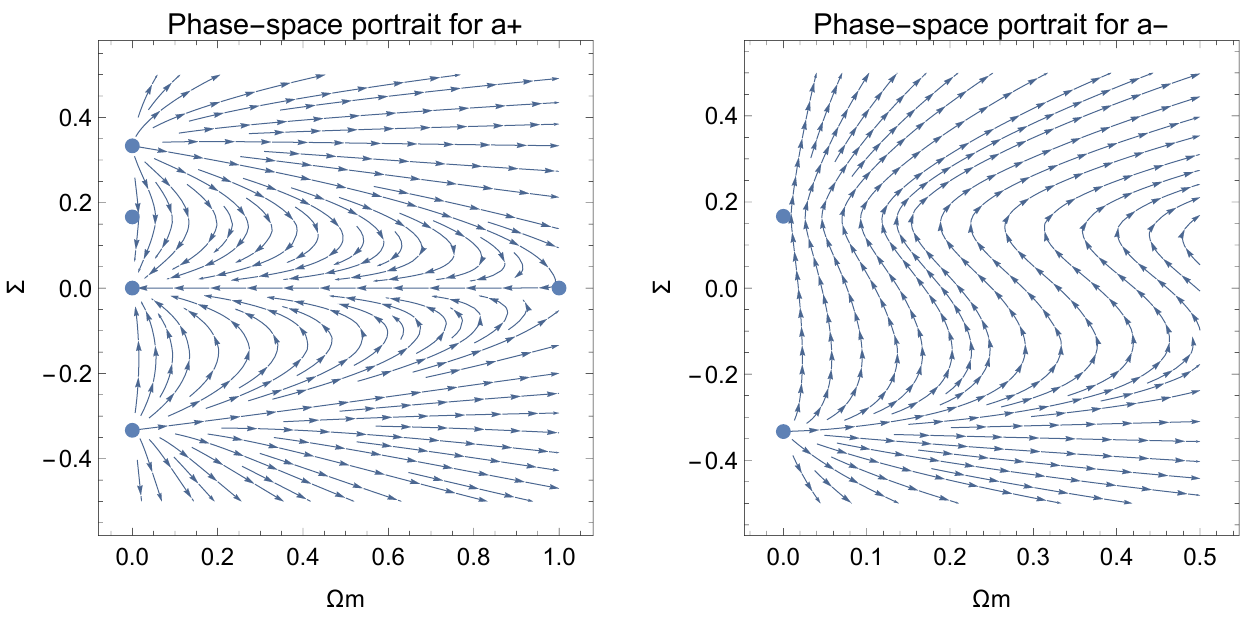
Figure 1. Phase-space portraits for the two-dimensional dynamical system (49) and (50) for α = α + ( Ω m , Σ ) ( left figure) and α = α − ( Ω m , Σ ) ( right